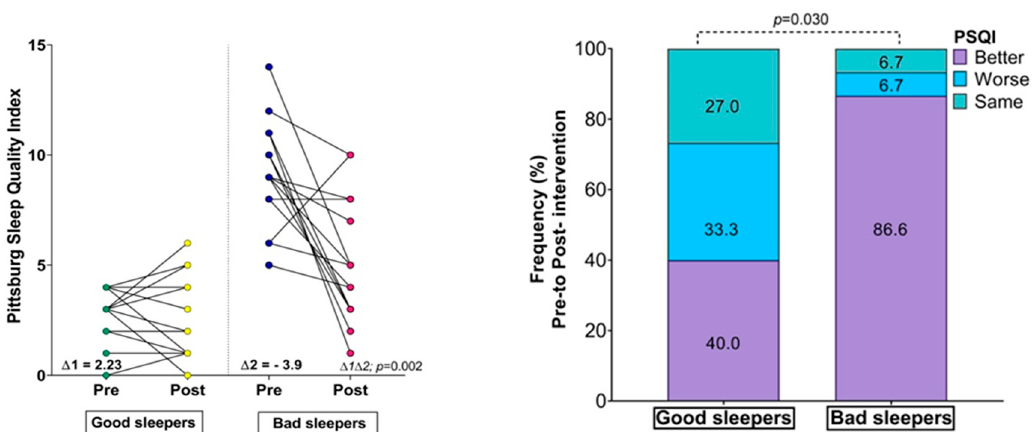
Figure 1. Changes in body mass index, physical fitness, and Sleep Quality Index; ( ∆ ) denotes delta changes from pre- to post-intervention. BMI = body mass index. p -value represents group × time interaction and McNemar test.